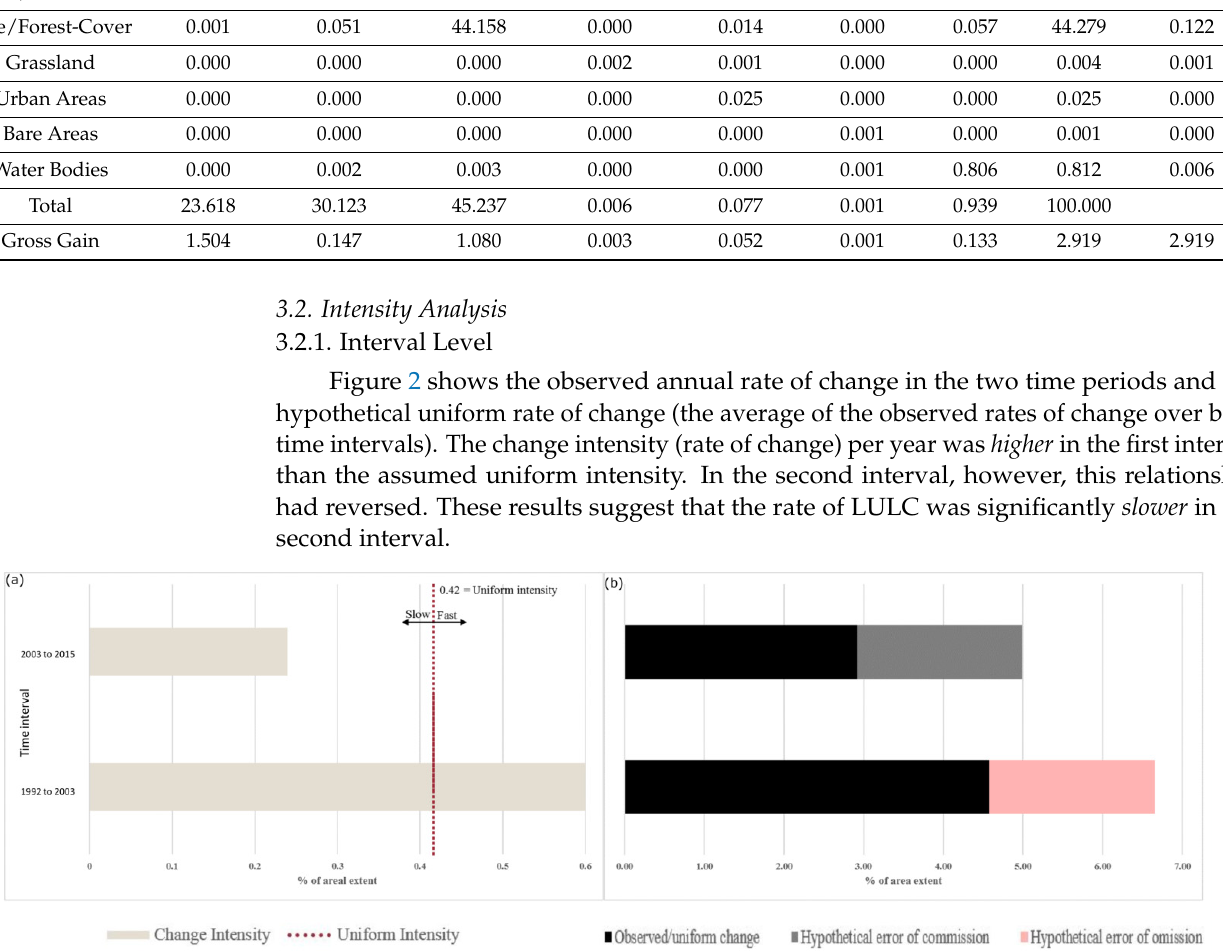
Figure 2. Intensity Analysis for interval-level changes of land category during the 1992–2003 and 2003–2015 time intervals for the study area showing ( a ) the observed change intensity (annual change averaged over the interval), and ( b ) the percentage of area that changed category over the